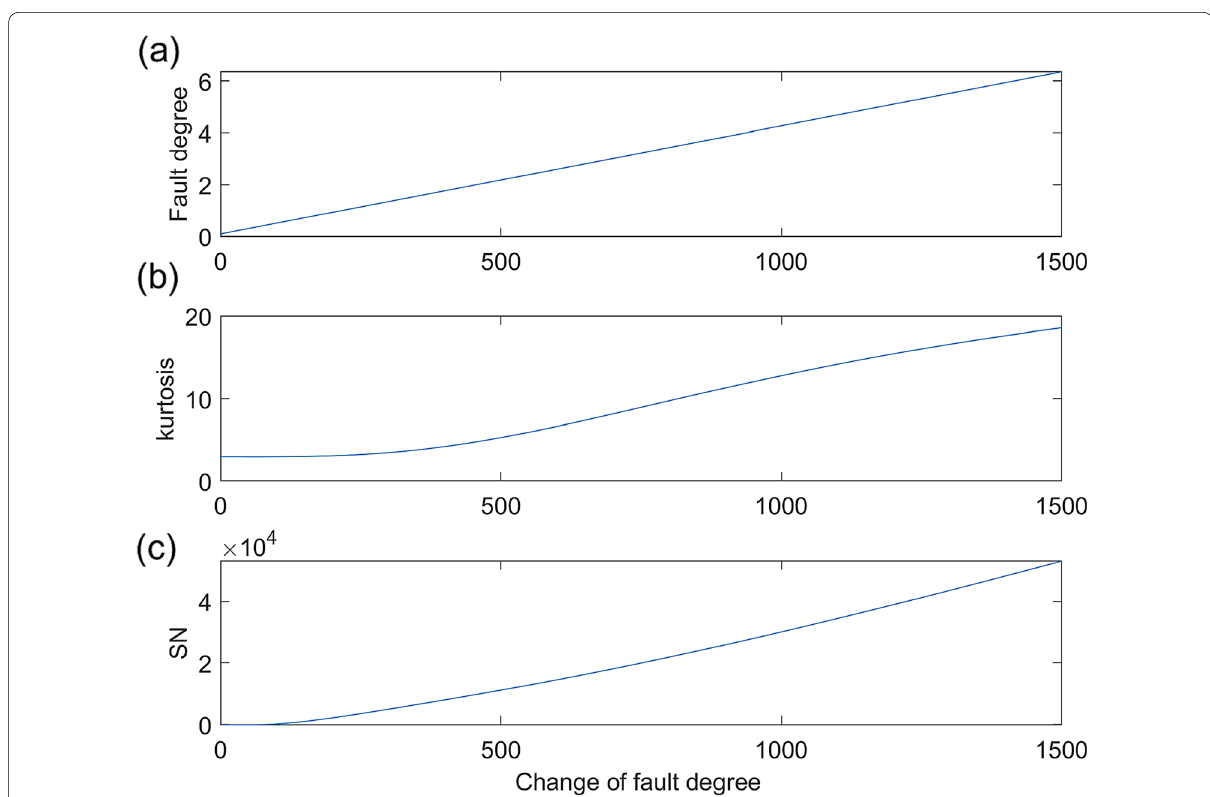
Figure 3 The change in kurtosis and SN values with the increase in fault degree: ( a ) the change in fault degree of 1500 simulation signals, ( b ) change in kurtosis value with increase in fault degree, and ( c ) change in SN value with increasing fault